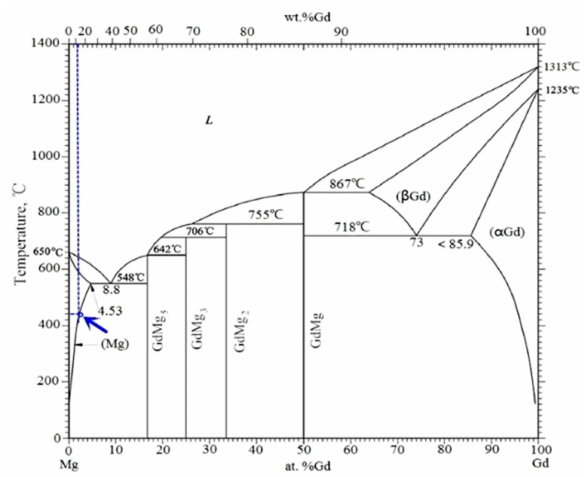
Figure 9. The Mg–Gd phase diagram.